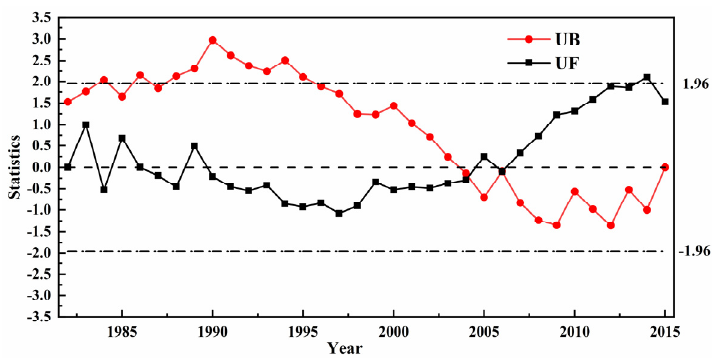
Figure A1. M-K test for annual precipitation.